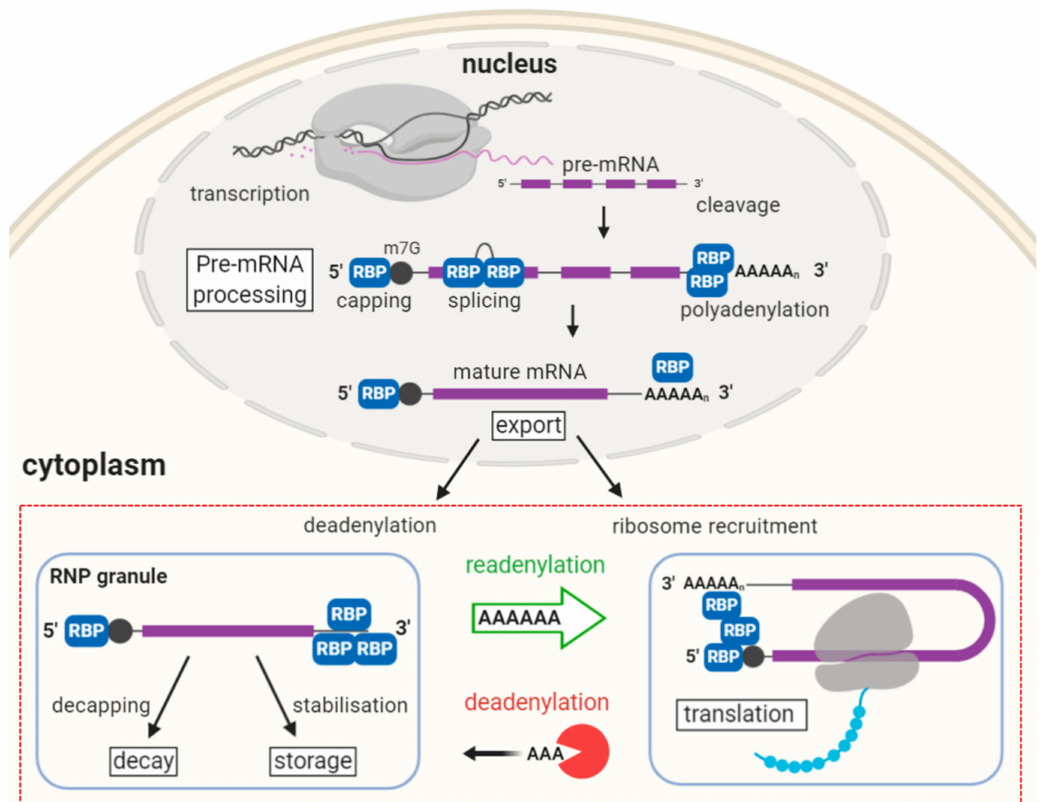
Figure 4. Nuclear and cytoplasmic post-transcriptional regulation in oocytes. The red box highlights the importance of cytoplasmic events in oocyte mRNA regulation. RBP: RNA-binding protein, RNP: Ribonucleoprotein. The purple block represents coding sequence and black circle represents the 7-methylguanylate (m7G)